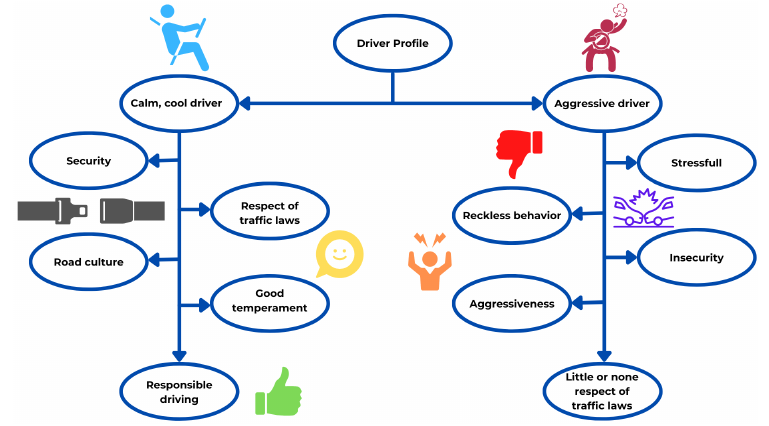
Figure 12. Cognitive